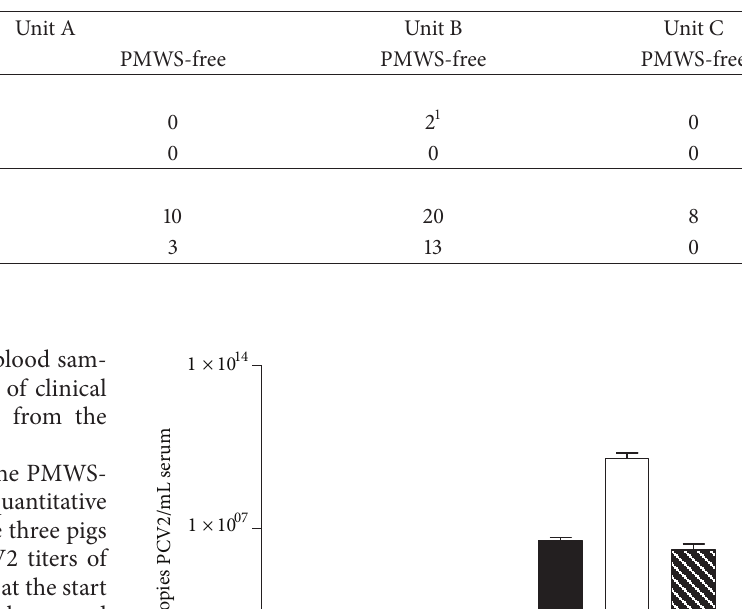
Table 3: Number of pigs diagnosed with PMWS.